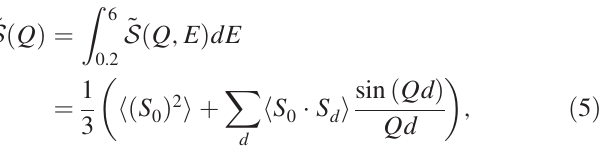
~ S ð Q Þ obtained by correcting FIG. 8. (a) Static structure factor for the Fe 2 þ form factor and integrating the measured intensity between 0 . 2 < E < 6 meV. Solid lines are a fit to a powder- averaged structure factor as described in the text. (b) First moment of the neutron scattering intensity integrated between 0 . 2 < E < 6 meV. The gray star indicates the Q ¼ 0 first moment as extrapolated from terahertz measurements and the static structure factor. Solid lines are a fit to the powder- averaged first moment sum rule described in the text. Gray dashed lines in (a) and (b) are the estimated phonon contribution. (c) Momentum-integrated inelastic scattering, integrated between 0 . 45 < Q < 1 . 6 Å − 1 . Error bars representing 1 standard deviation are smaller than the symbol